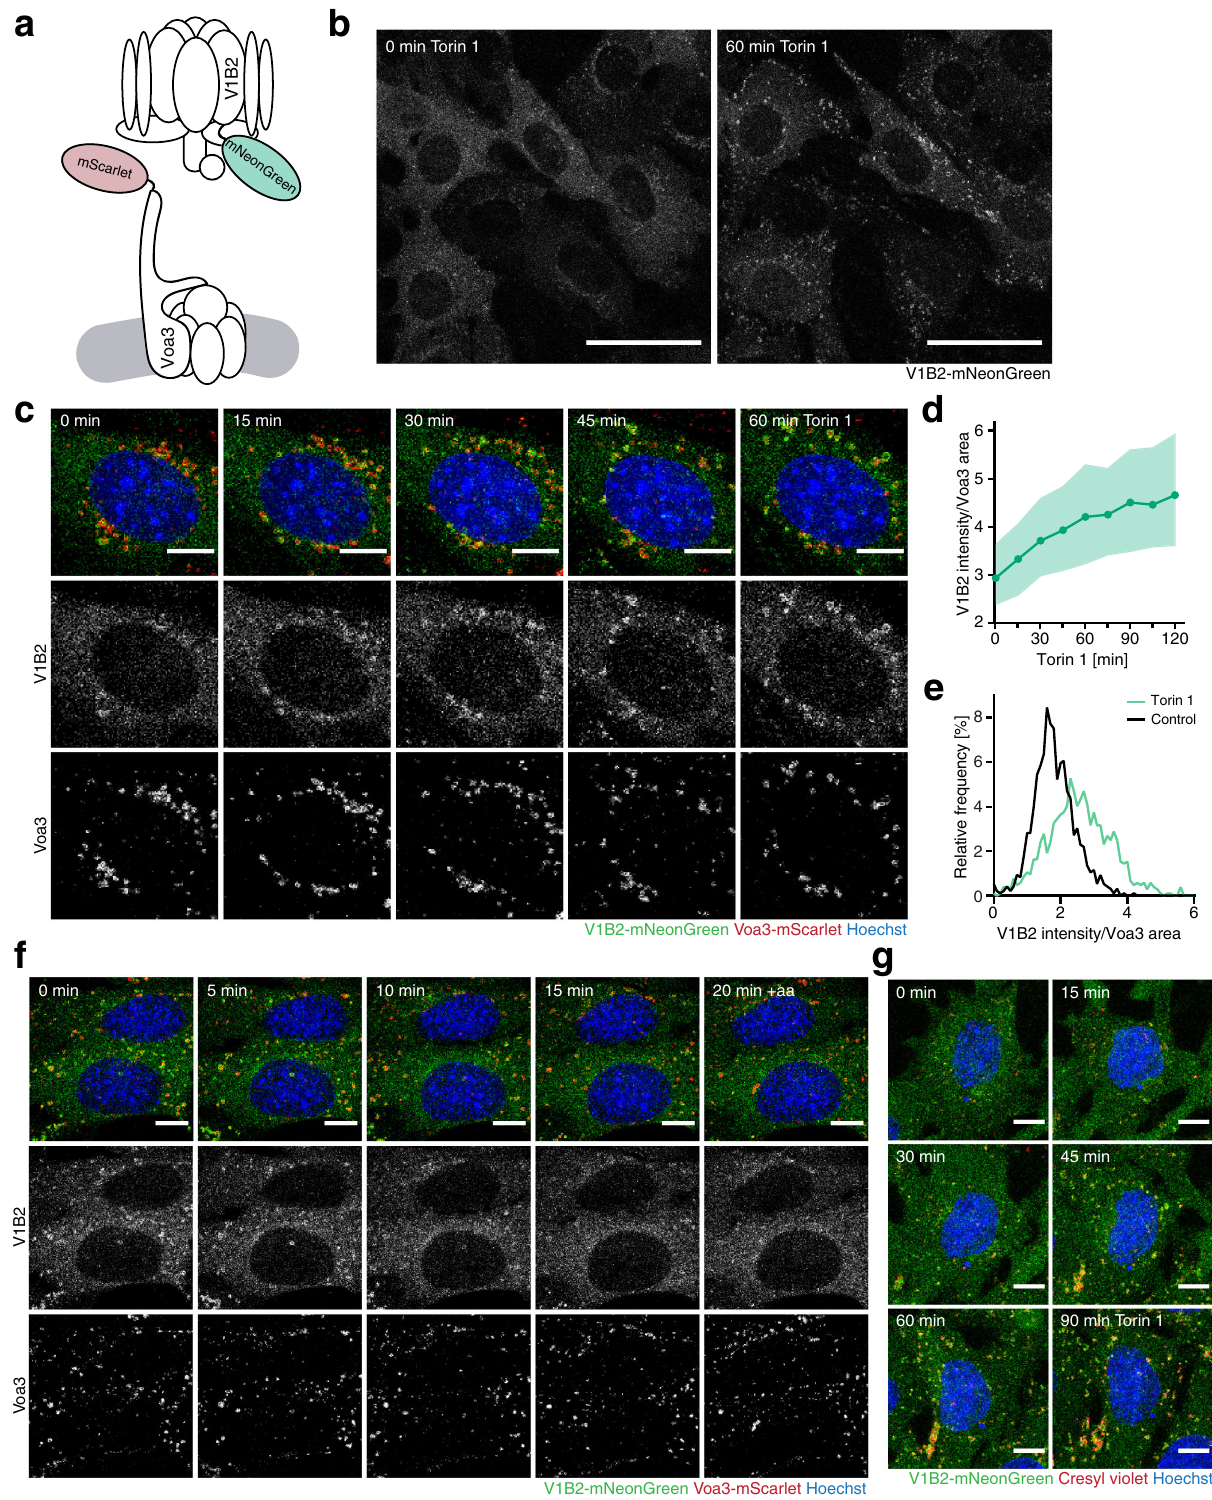
Fig. 4 | mTORC1 controls reversible assembly of the V-ATPase at lysosomes. a Schematic of the live cell imaging assay for lysosomal V-ATPase assembly. b Subcellular localization of V1B2-mNeonGreen before and 60min after treatment with torin 1 [400nM]. Scale bars = 50 µ m. c Subcellular localization of V1B2-mNeonGreen and Voa3-mScarlet in MEFs over time after addition of torin 1 [400nM]. Scale bars= 10 µ m. d Quanti fi cation of V1B2-mNeonGreen recruitment to Voa3-mScarlet-containing lysosomes in cells shown in c . Data are represented as median± IQR ( ≥ 7000 organelles in 12 fi elds of view with a